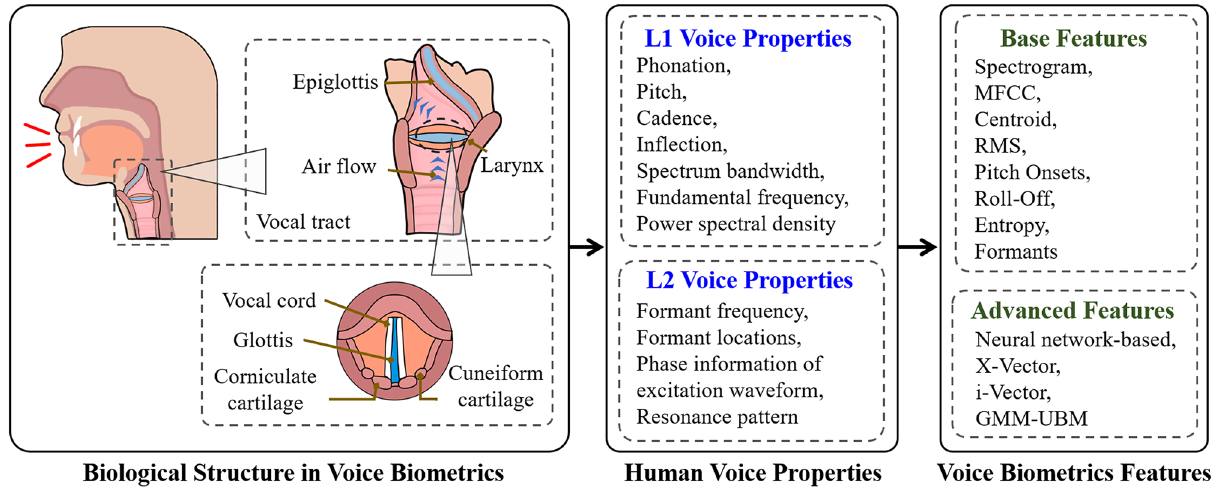
Figure 6. A taxonomy of the vocal biological structure, voice properties, and computational voice features for voice